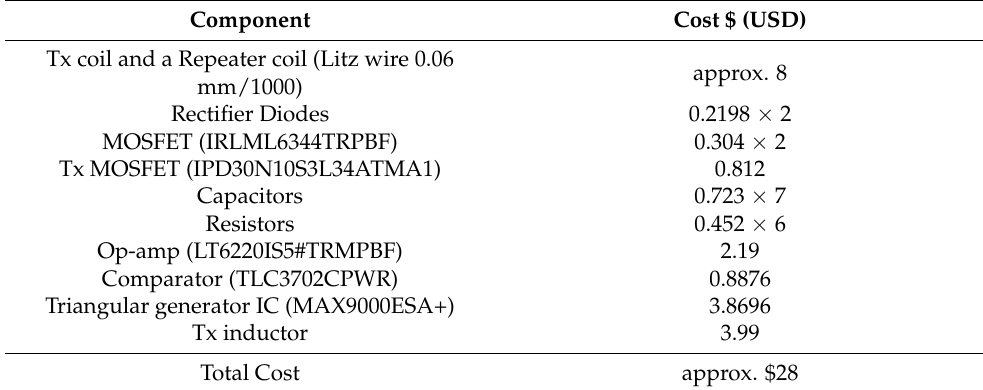
Table 3. Component